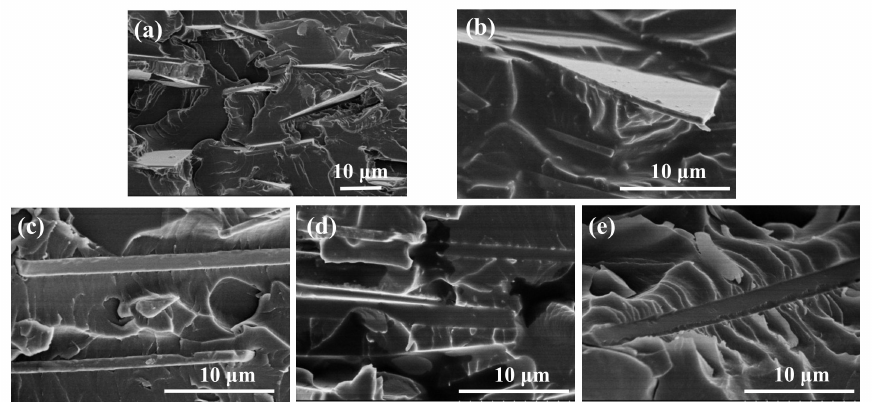
Figure 3. SEM images of the section morphology of CNT-BF / EP coating. ( a ) BF / EP; ( b ) 0.1 CNT-BF / EP; ( c ) 0.3 CNT-BF / EP; ( d ) 0.5 CNT-BF / EP; ( e ) 0.7 CNT-BF / EP.